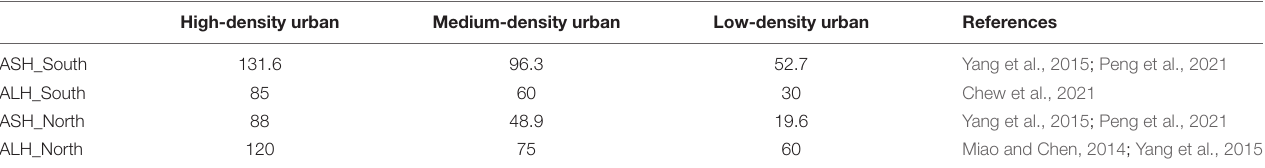
TABLE 3 | ASH and ALH releases in high-/medium-/low-density urban areas used in this study. The diurnal cycles of ASH and ALH (W m − 2 ) profiles in high-, medium- and low-density cities refer to Figures 1g,i